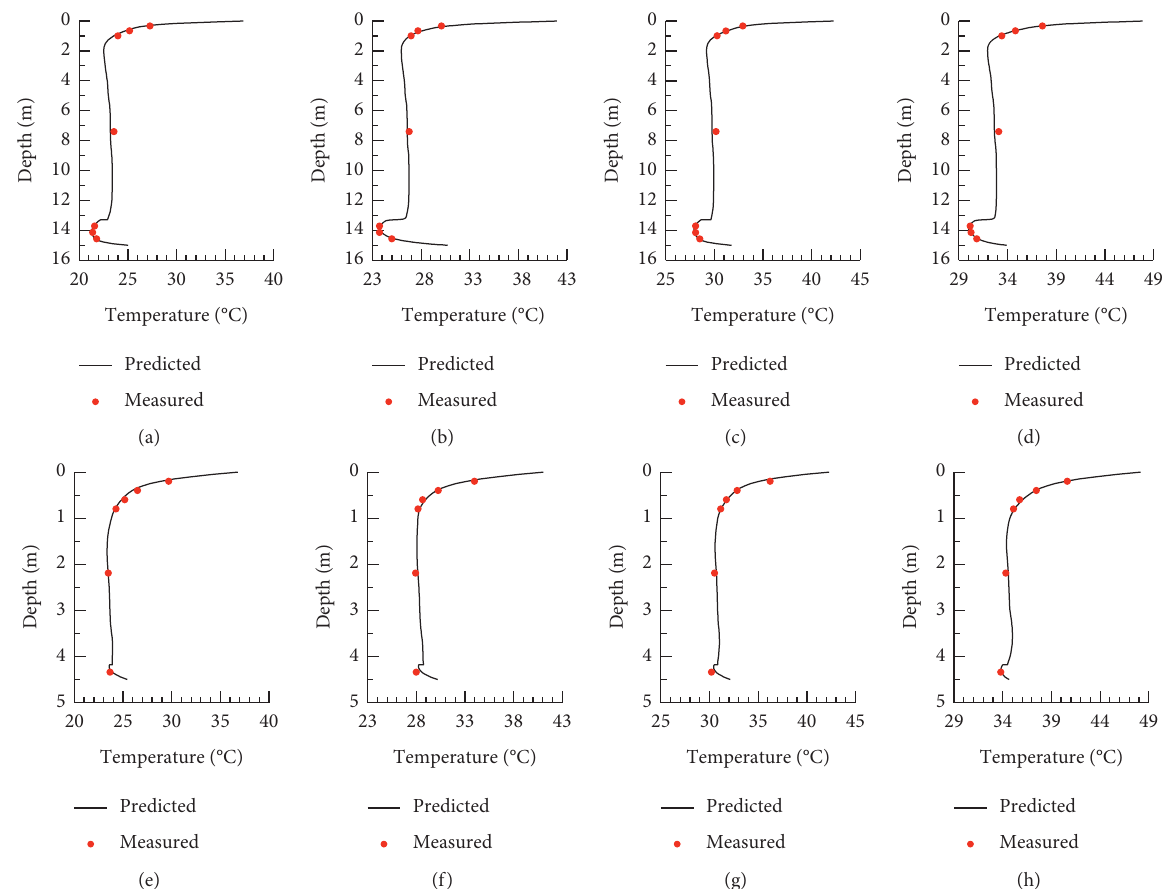
Figure 12: The predicted vertical temperature distributions along the depth of the girder for the four sunny days: (a) section T1 on June 7, 2010; (b) section T1 on June 19, 2010; (c) section T1 on July 22, 2010; (d) section T1 on August 3, 2010; (e) section T2 on June 7, 2010; (f) section T2 on June 19, 2010; (g) section T2 on July 22, 2010; (d) section T2 on August 3,